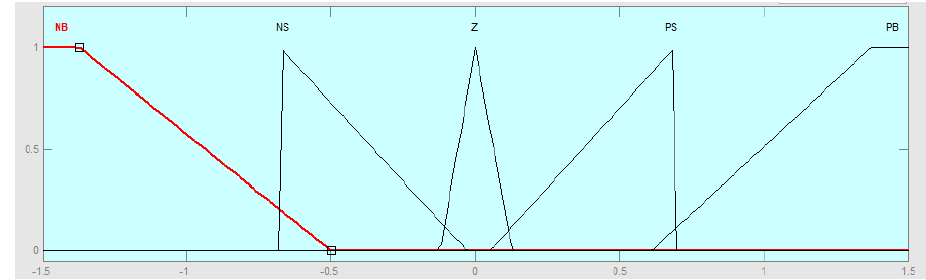
Figure 7. Membership output of pulse width modulator (PWM).